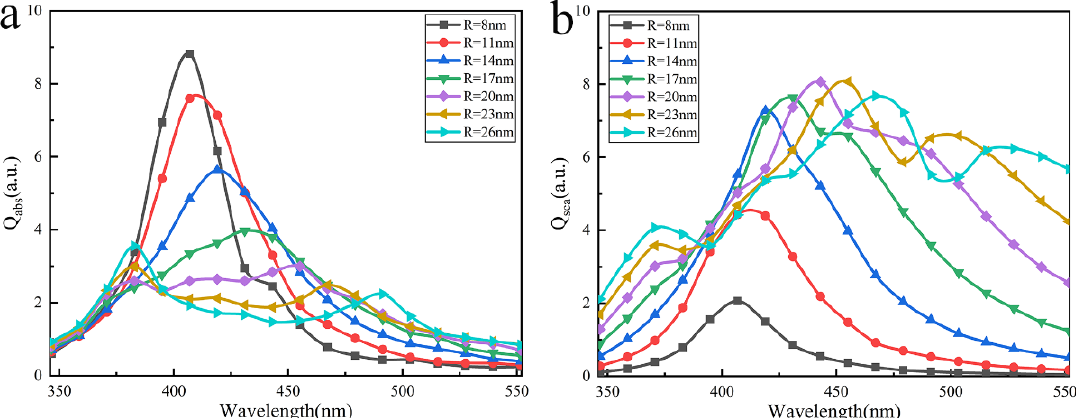
Figure 5. The absorption and scattering efficiencies of the 3 × 3 square array of Ag nanoparticles with different particle radiuses with spacing 10 nm : ( a ) absorption efficiency ( b ) scattering efficiency.